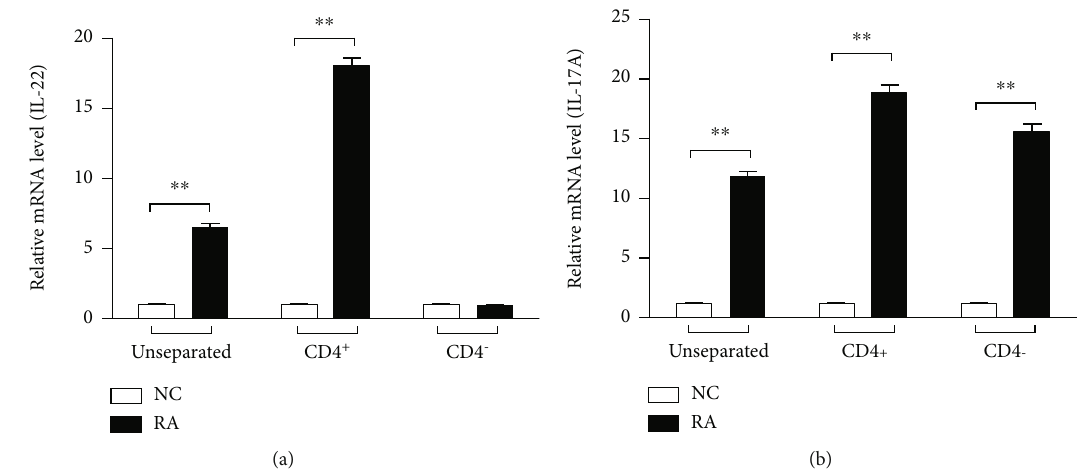
Figure 5: IL-22 is produced primarily by CD4 + cells during R. anatipestifer infection, but not IL-17. The spleens were collected from 2- week-old healthy ducks. Spleen cells were isolated, cultured, and stimulated with heat-killed R. anatipestifer serotype 7. After 24 h, cells were collected, labelled, and separated following incubation in MACS bu ff er. Total RNA was obtained, and qRT-PCR analysis was performed. Gene expression levels of IL-22 (a) and IL-17A (b) transcripts were normalized with β -actin used as a reference gene and calibrated with the expression levels of untreated cultured spleen cells (NC). These results represented one representative of 2 independent experiments. Results are presented as the mean ± SE values performed in triplicate. ∗∗ P < 0 : 01 . RA: splenic lymphocytes stimulated with heat-inactivated R. anatipestifer